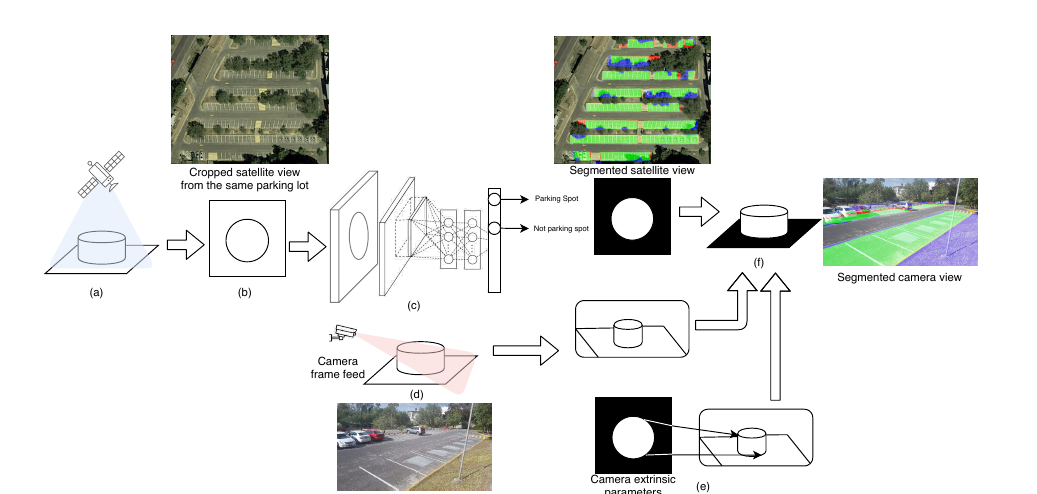
Figure 2. Our Proposal. First, a satellite photo perspective of the same parking area ( a ) is cropped and scaled ( b ). The image is then segmented by a pre-trained Convolutional Neural Network (CNN) residual network ( c ). In parallel, a new frame is taken by the surveillance camera ( d ). With the help of correspondence or coordinate points previously calculated, the homography between the new surveillance camera image and the satellite perspective ( e ) is calculated. The homography is then applied to extrapolate the satellite CNN segmentation to the surveillance camera image ( f ). Red overlay stands for false negatives, blue for false positives and green for true